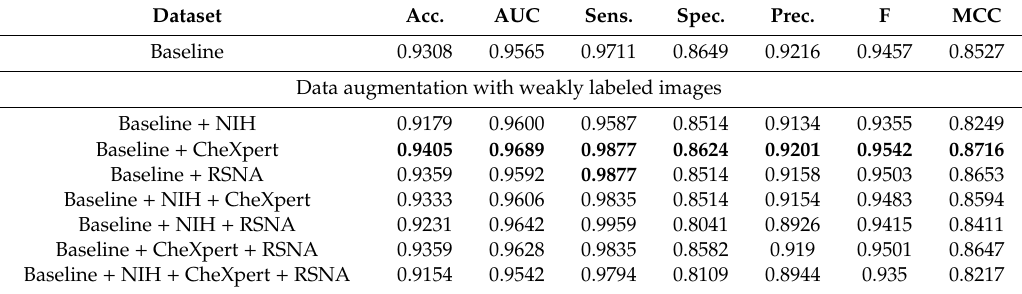
Table 8. Performance metrics achieved with the di ff erent combinations of augmented training data toward classifying the pediatric CXR (baseline) test data into bacterial and viral pneumonia categories.